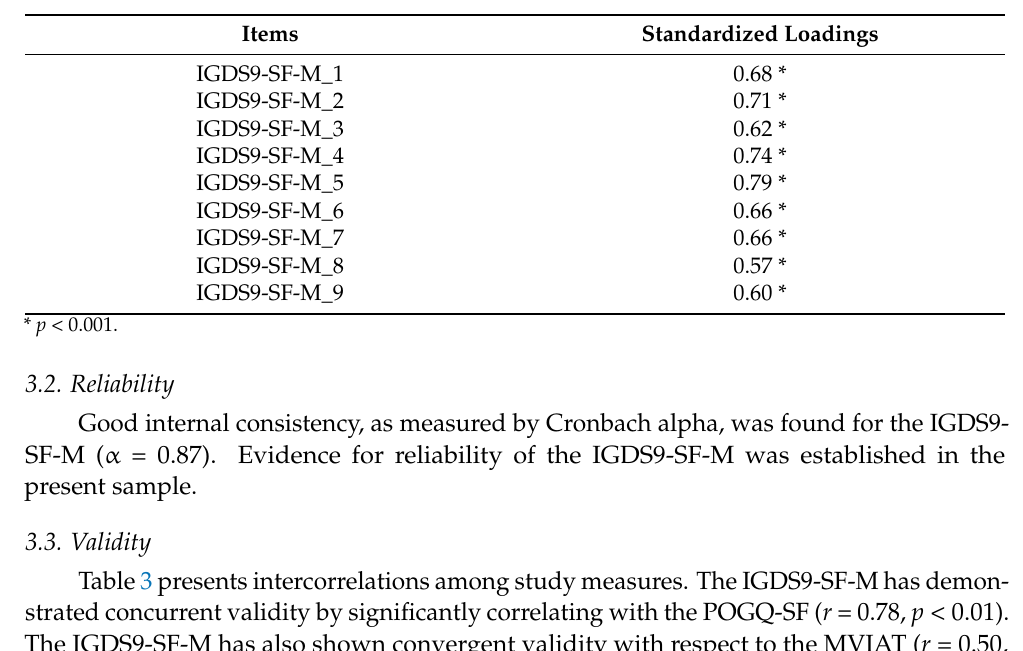
Table 2. Standardized factor loadings for the one-factor IGDS9-SF-M model in the confirmatory factor analysis.